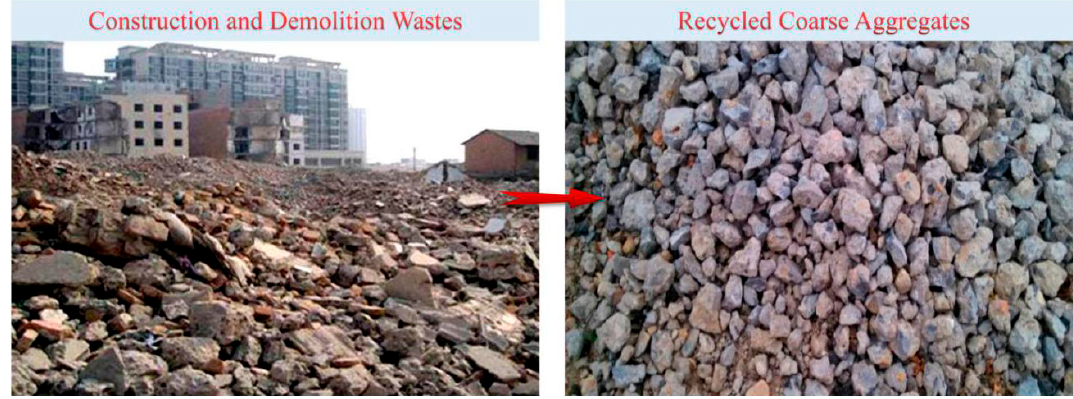
Figure 1. Recycled coarse aggregates.